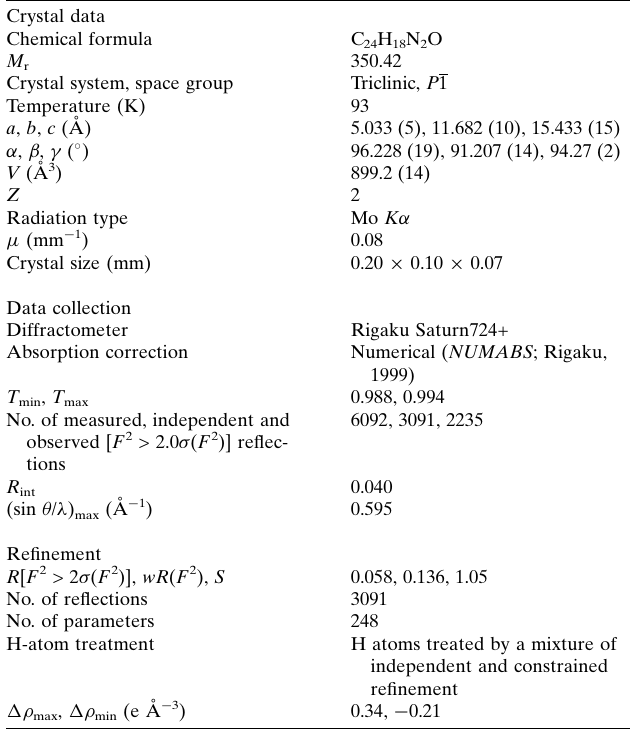
Table 2 Experimental details.